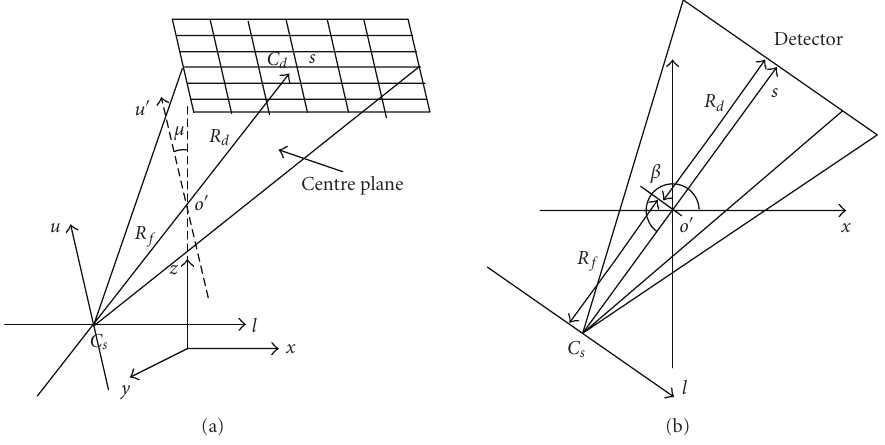
Figure 1: Geometry for gantry-tilted multislice CT